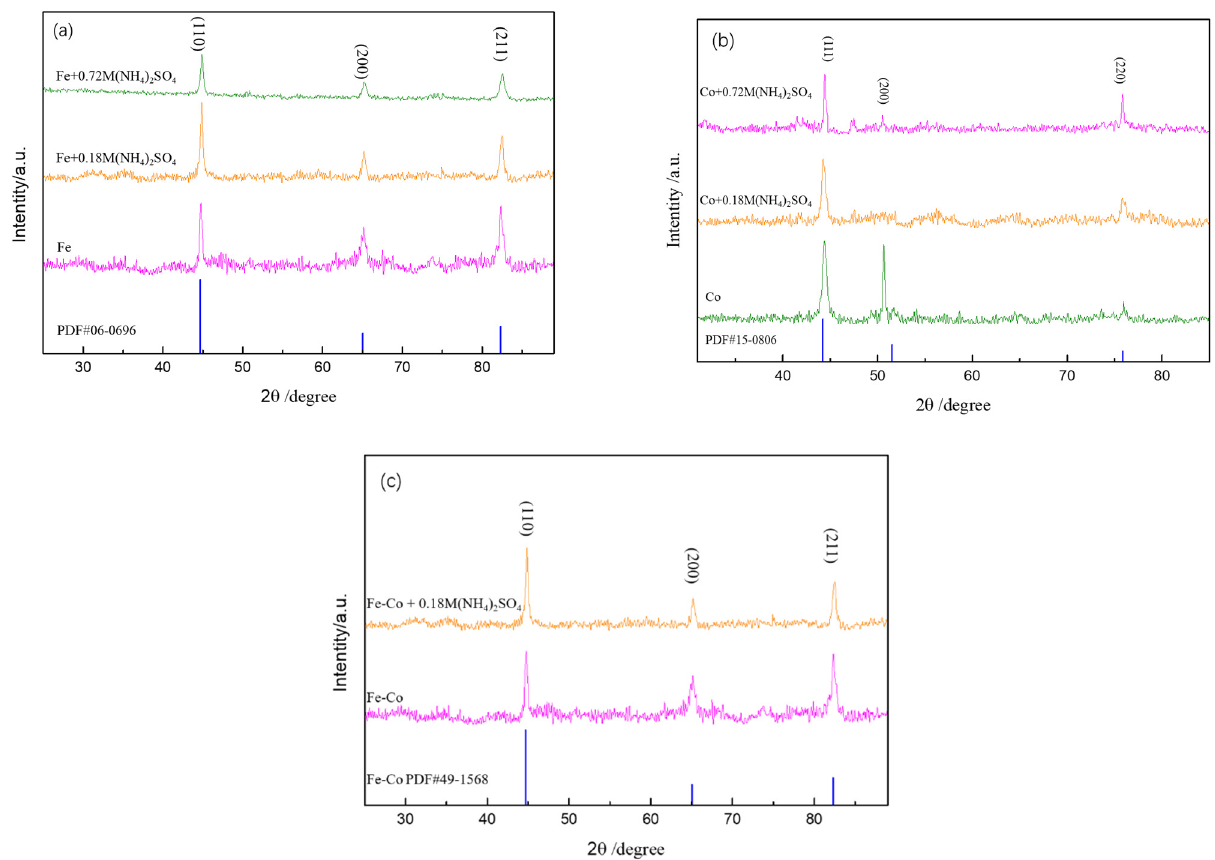
Figure 12. XRD patterns with and without (NH 4 ) 2 SO 4 . ( a ) Fe 2+ solution; ( b ) Co 2+ solution; ( c ) Fe 2+ and Co 2+ solution.